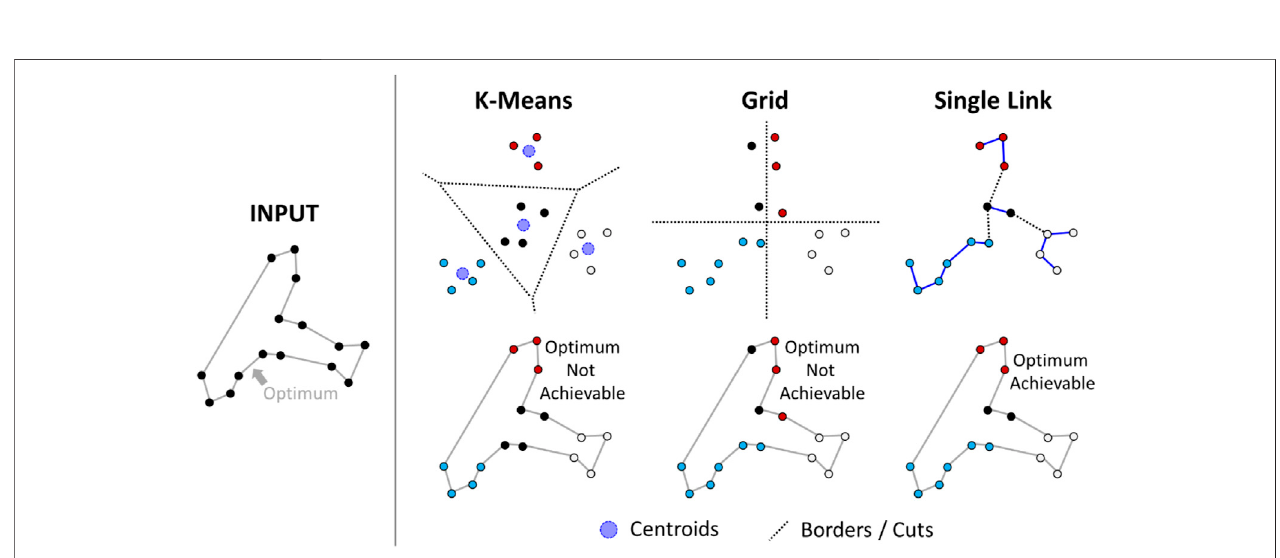
FIGURE 5 | An exampleofaTSPinstance divided intoclusters in threedifferent ways. Theoptimum cannot beachievedwhen it entersthe same clustermorethanonce.